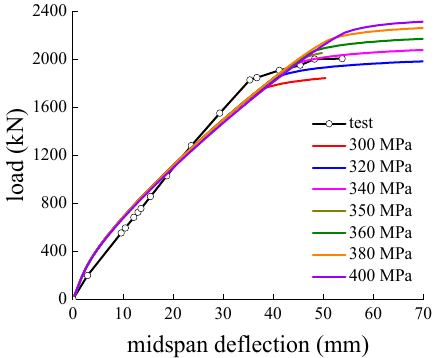
track structure on the bridge has been ignored in the calculation.